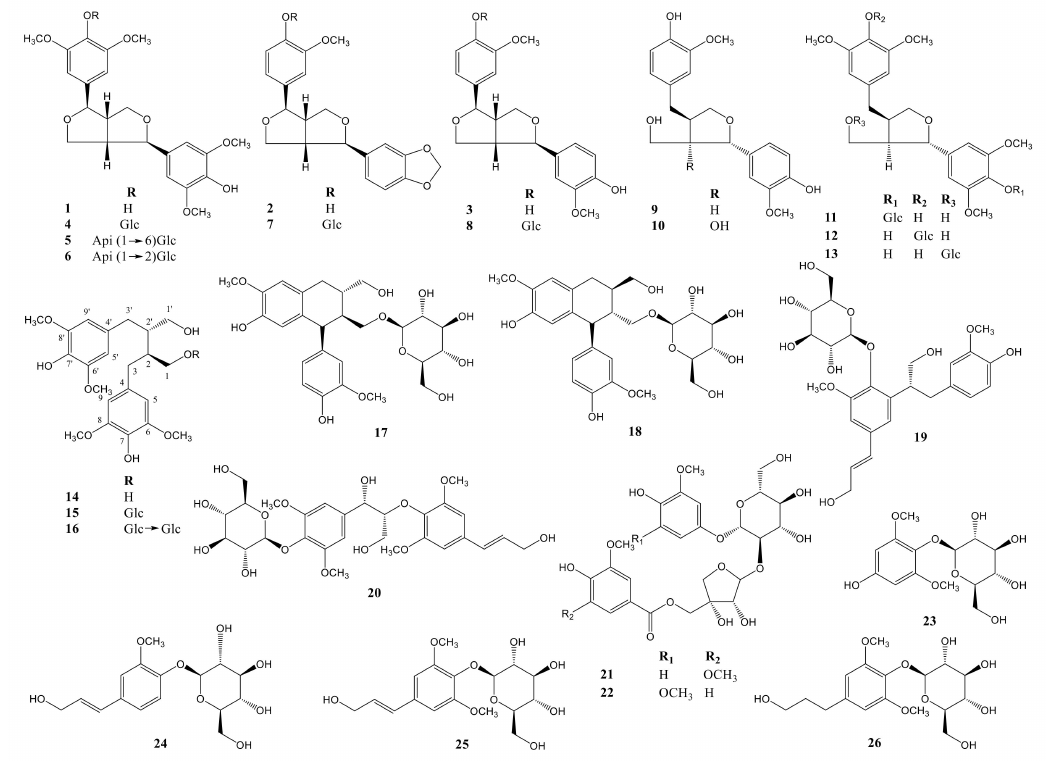
Figure 2. Structures of compounds 1 – 26 from A.